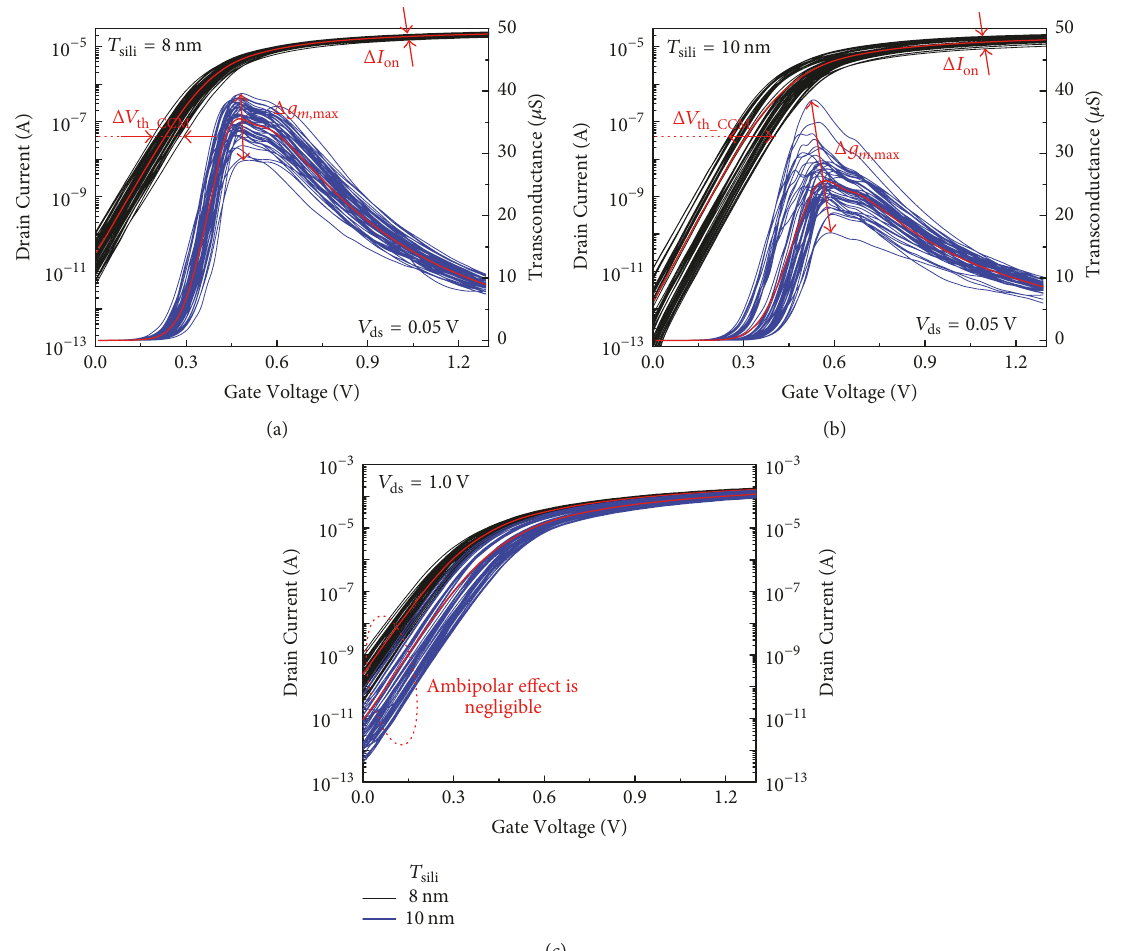
of (a) 8 and (b) 10nm at drain voltage ( 𝑉 sili . sili